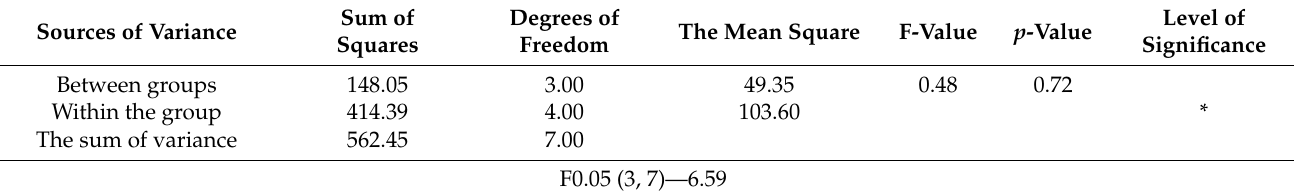
Table 7. Analysis of variance of concrete 14 − day compressive strength.